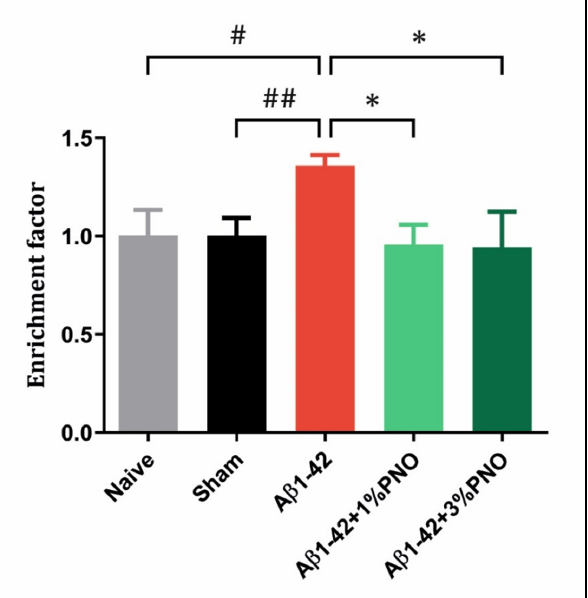
Figure 7. Effects of the inhaled Pinus halepensis essential oil (PNO, 1%, and 3%) on apoptotic state determined in the rat amygdala homogenates of the A β 1-42-treated rats. Values are means ± S.E.M. ( n = 5). A β 1-42 vs. Naive: # p = 0.0229; A β 1-42 vs. sham: ## p = 0.0026; A β 1-42 vs. A β 1-42 + 1% PNO: * p = 0.0129 and A β 1-42 vs. A β 1-42 + 3% PNO: * p = 0.0265.